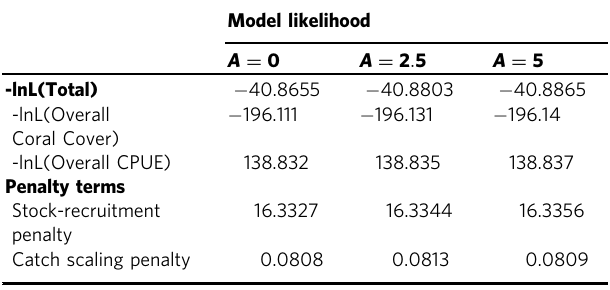
Table 1 Summary of likelihood contributions arising from each data source (coral cover data and catch-per-unit-effort data (CPUE)) and encompassed penalty terms.